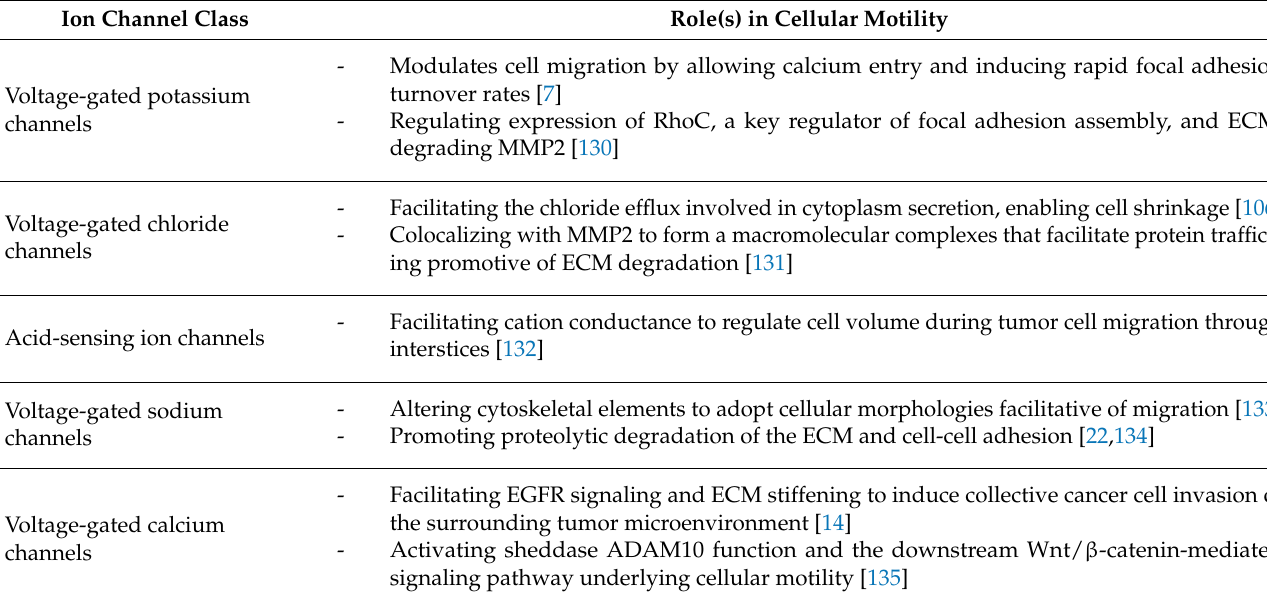
Table 2. Reported roles of ion channels in cellular invasion and migration